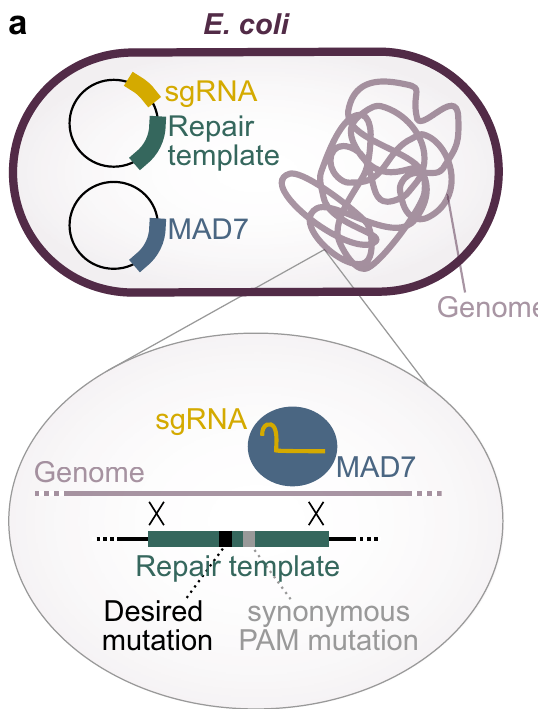
Fig. 1 | Construction of saturation editing libraries of E. coli FabZ, LpxC and MurA using high-throughput CRISPR genome editing. a For CRISPR-based editing,twoplasmidswereintroducedintoindividual E.coli cells.The fi rstplasmid, the ‘ engine plasmid ’ encodes the MAD7 enzyme used for genomic cutting. The second plasmid, the ‘ barcode plasmid ’ , encodes the sgRNA and repair template. The repair template is incorporated into the E. coli genome by homologous recombination and contains the desired edit as well as one or more synonymous